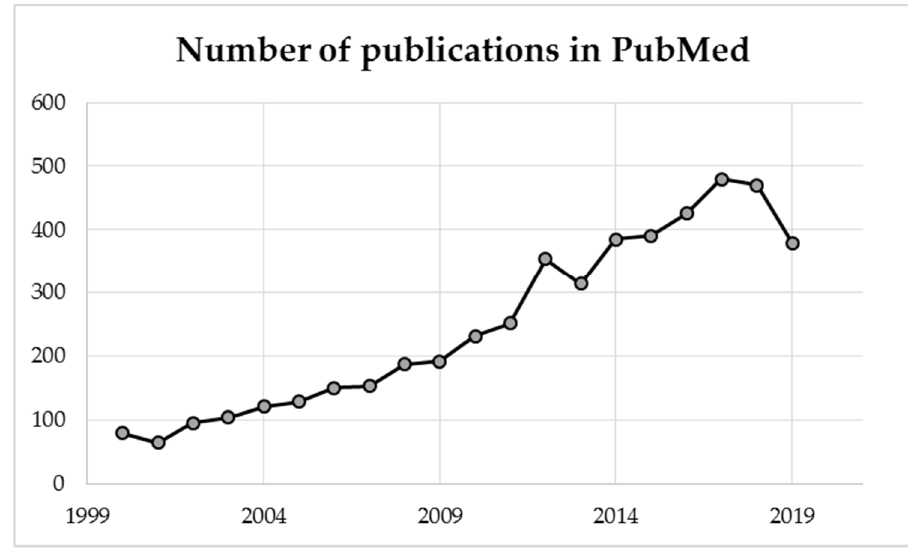
Figure 1. Number of publications in the PubMed database with the word “honey” in the title.